Question: What style of plot is this figure drawn as?
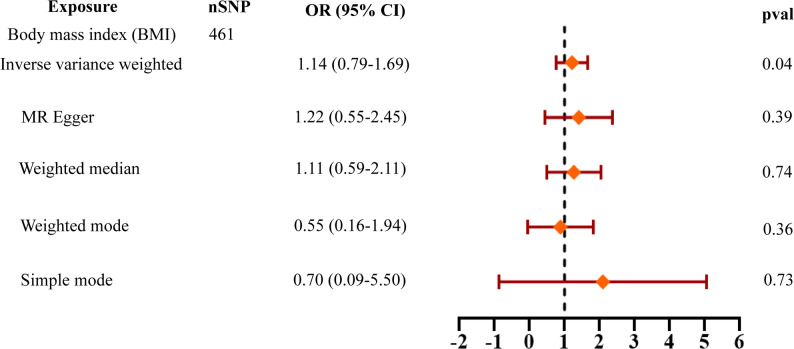
Answer: forest